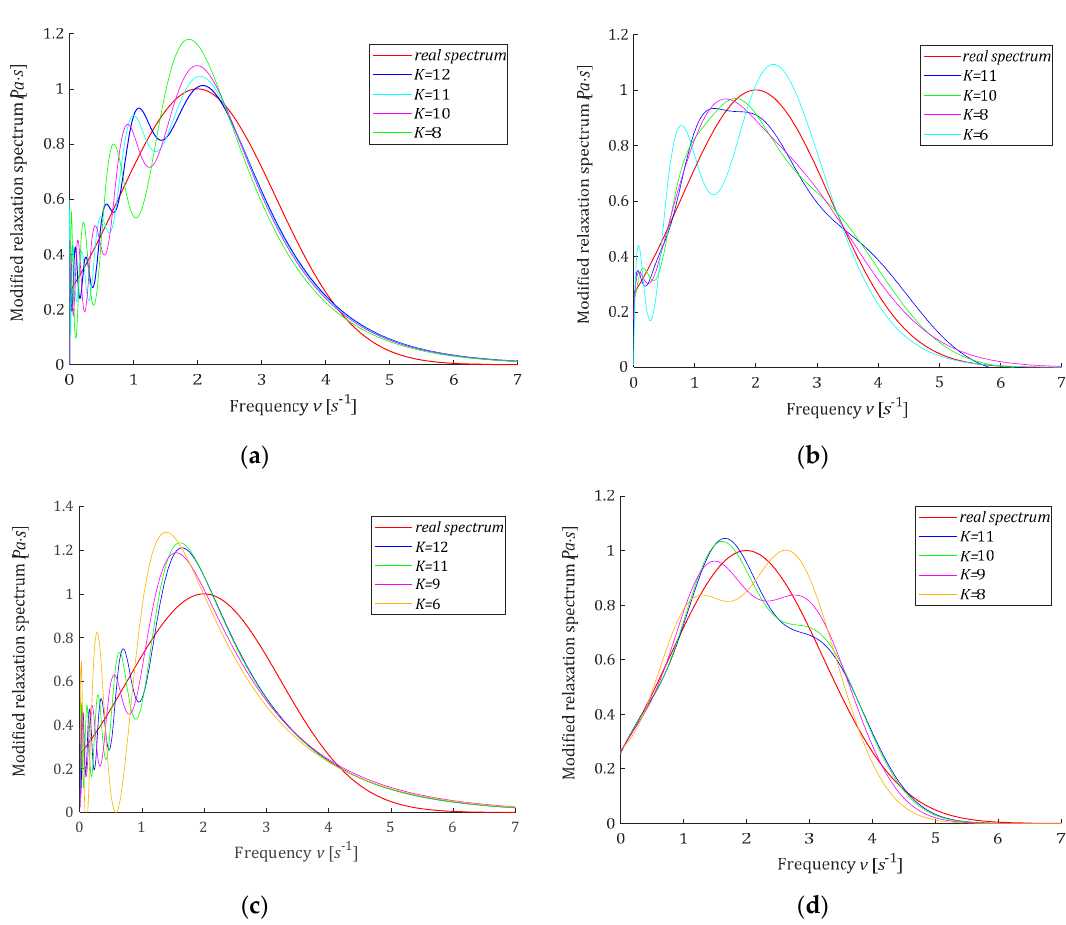
Figure 5. Modified relaxation spectrum H M ( v ) (58) (solid red line) from Example 1 and the approxi- mated models 𝐻(cid:3365) (cid:3012)(cid:3014) (𝑣) : ( a ) Legendre, ( b ) Laguerre, ( c ) Chebyshev, ( d ) Hermite.